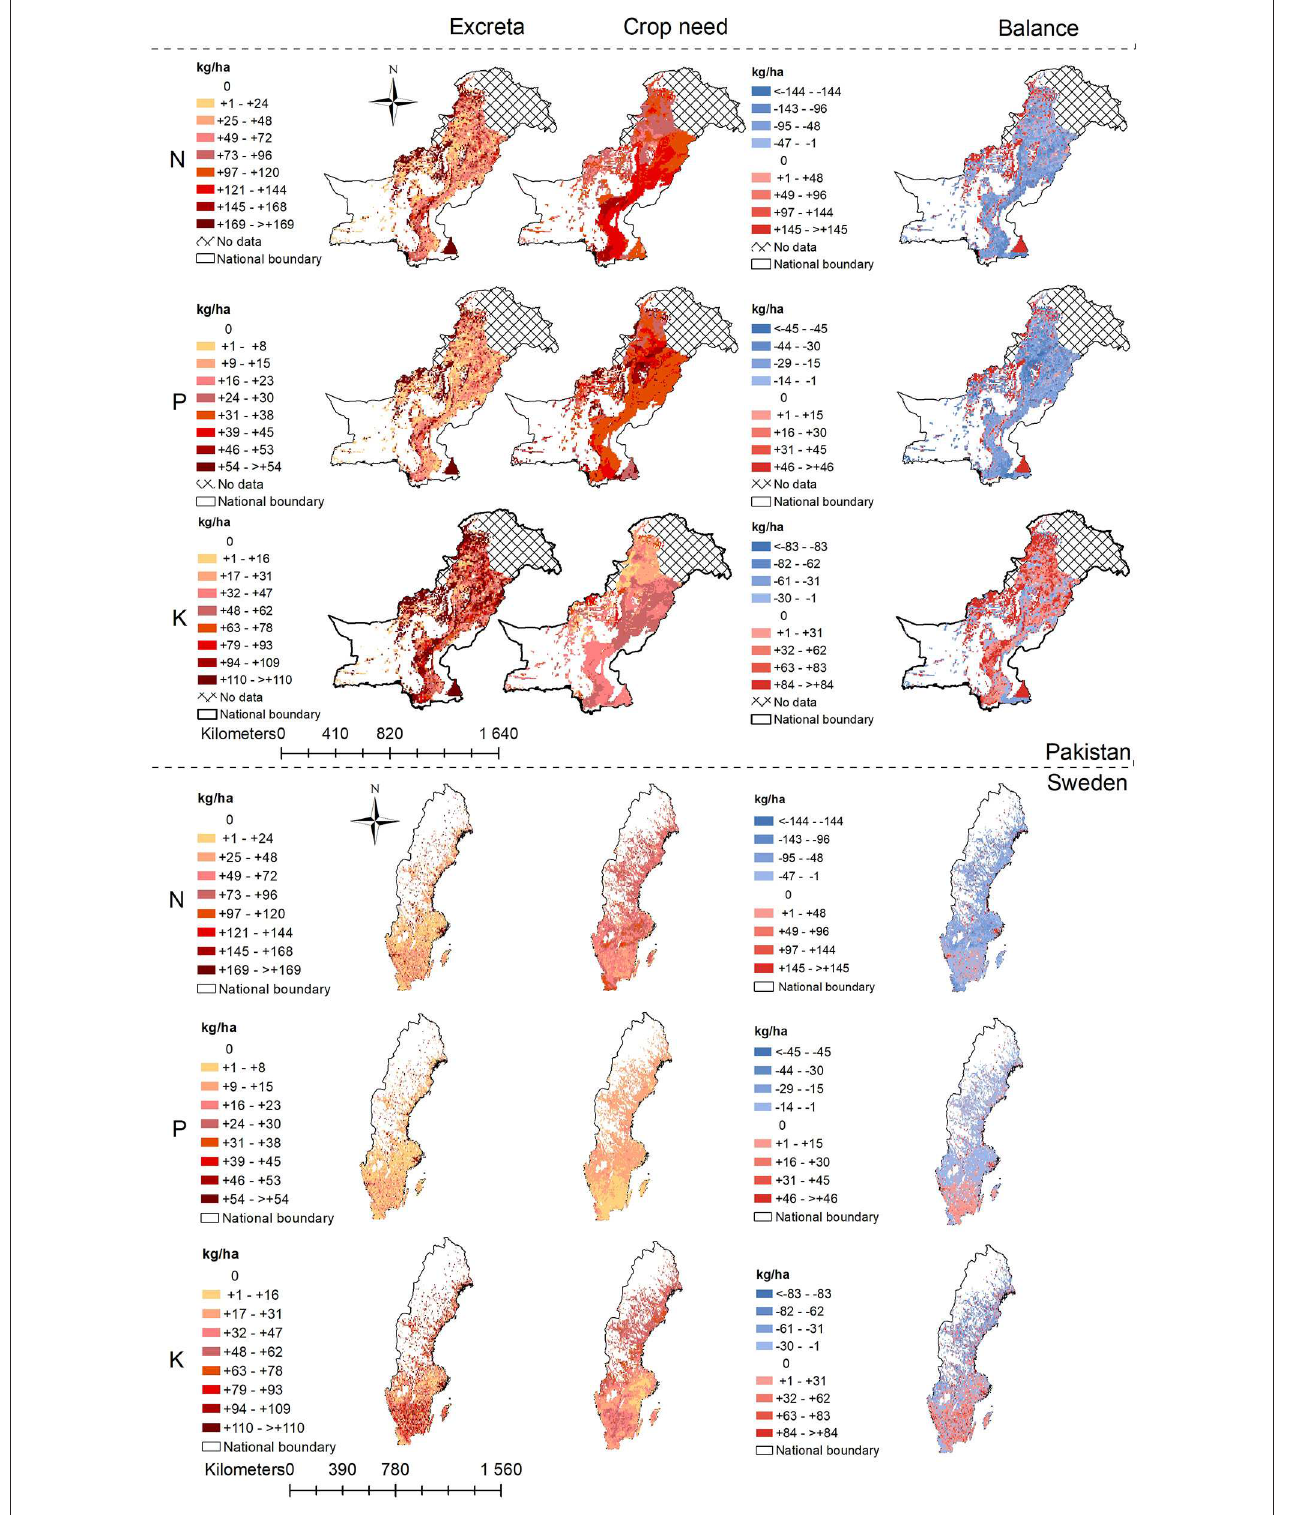
FIGURE 2 | Spatial distribution of excreta nutrient supply, crop nutrient needs, and nutrient balances as nitrogen (N), phosphorus (P), and potassium (K) at the 0.083 decimal degree grid resolution in Pakistan (top three rows) and Sweden (bottom three rows).